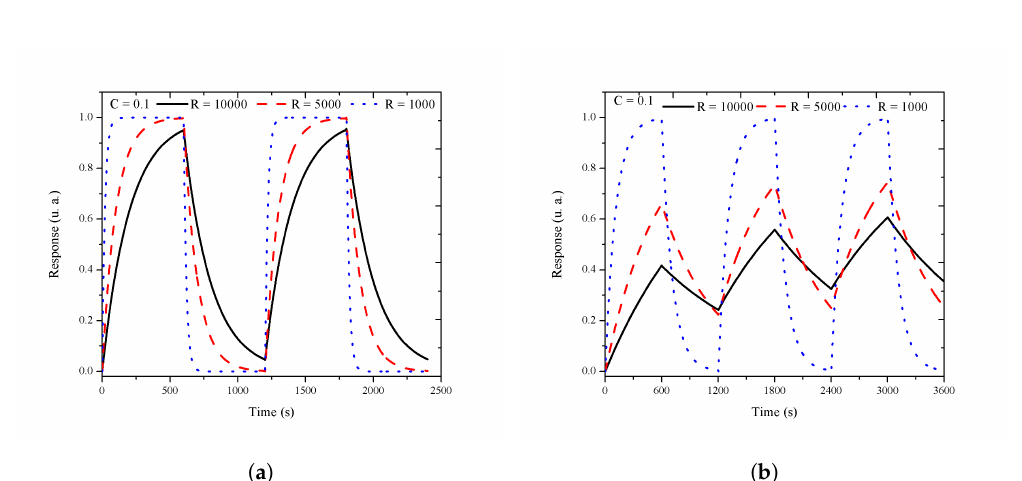
Figure 8. The RC circuit response. ( a ) Normalized response R vs. time with C = 0.1 F and R = 1, 5, and 10 k Ω . ( b ) Three cycles of 20 min, with 10 min for the exposure period and 10 for the recovery